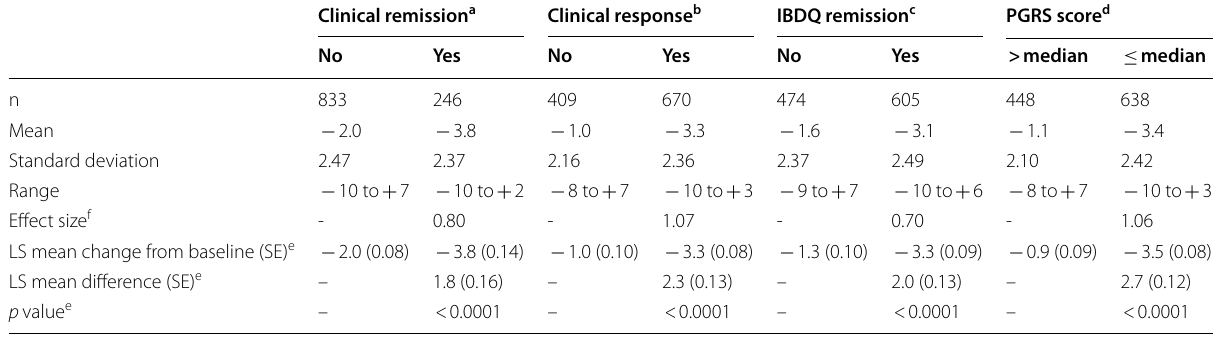
Table 5 Responsiveness at week 12 based on clinical remission, clinical response, IBDQ remission, and median PGRS